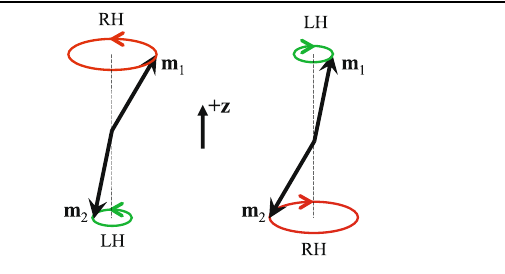
Fig. 1 | Schematic of the two eigenmodes of antiferromagnetic magnons in an easy-axis antiferromagnet. For both eigenmodes, the precessions of m 1 and m 2 have opposite chiralities around their equilibrium directions. Right-handed (left- handed) chirality is depicted in red (green).